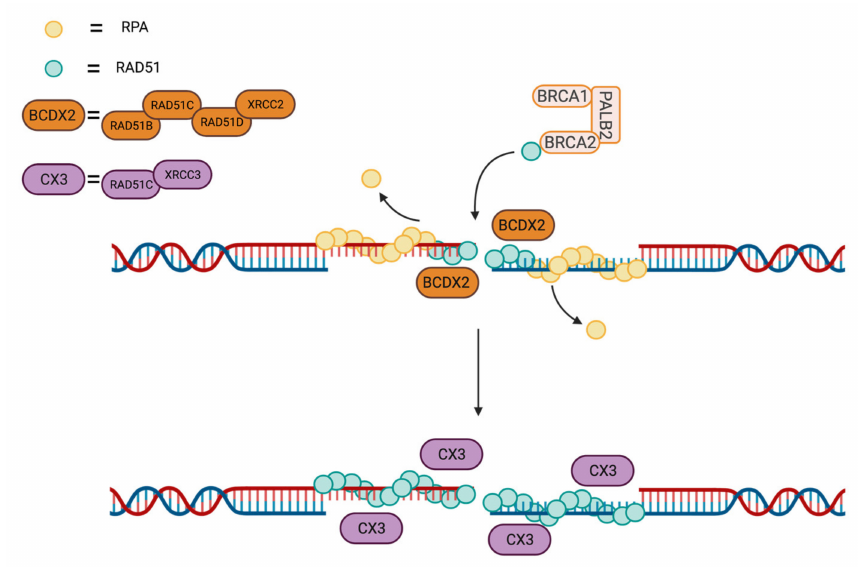
Figure 5. Intervention of RAD51 cofactors in RAD51 loading and stabilization of the filaments. The BCDX2 intervenes at early stages of RAD51 loading, while CX3 stabilizes the filaments onto the